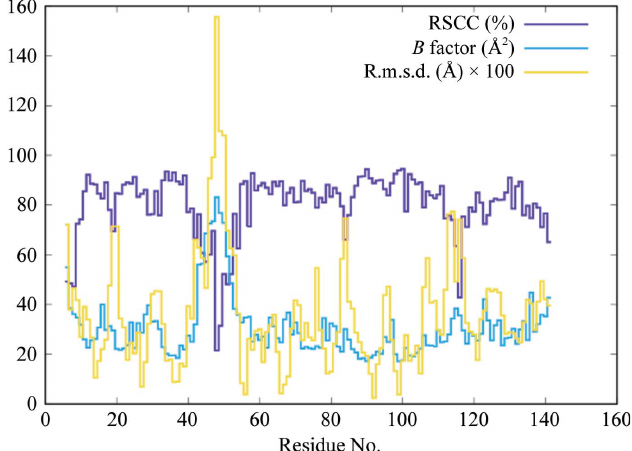
Figure 6 Residue-wise comparisons between the simulated structure factors and the crystal structure. The real-space correlation coefficient (purple line) is computed using the crystal structure and the simulated Bragg reflections. The isotropic B factors (blue line) are taken from the crystal structure. The r.m.s.d. of heavy-atom atomic coordinates (yellow line) is computed between the average structure from the simulation and the crystal